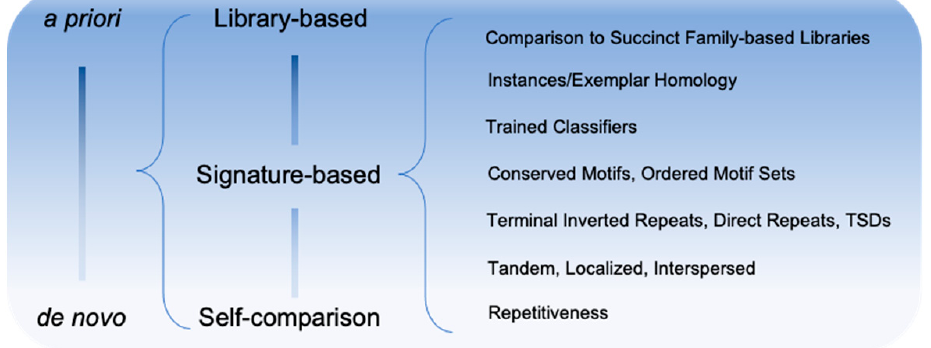
Figure 1. Spectrum of methodologies for the discovery of TE sequences.